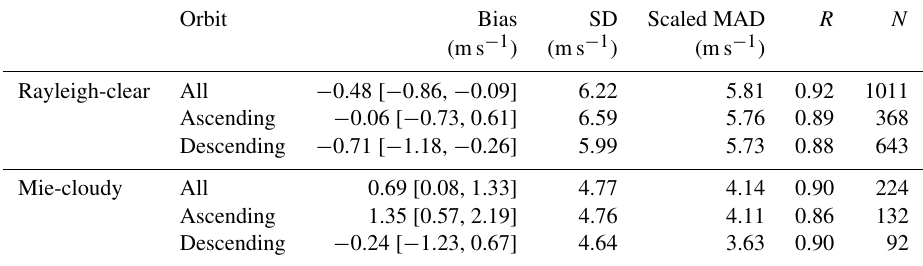
Table 3. Results of inter-comparison with ground-based WPR measurements.